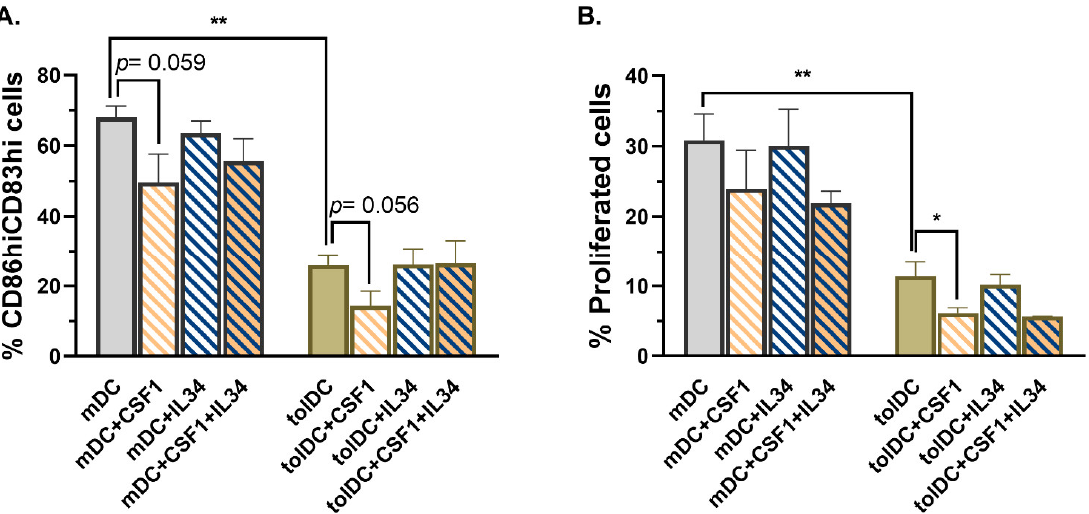
Figure 5. CSF1-CD115 engagement induces tolerogenic properties. Analysis of phenotype (% CD83 hi CD86 hi cells) ( A ) and functional characteristics (ability to induce allogeneic PBMC proliferation using a ratio of DC/PBMC of 1/20) ( B ) of mDC and VitD3-tolDC exposed to CSF1 and/or IL34 (ligands of CD115) during culture differentiation. Data are shown as mean + SEM. For all groups, n = 5, except for mDC + CSF1 + IL34 and tolDC + CSF1 + IL34 in which n = 2. * p < 0.05; ** p < 0.01.